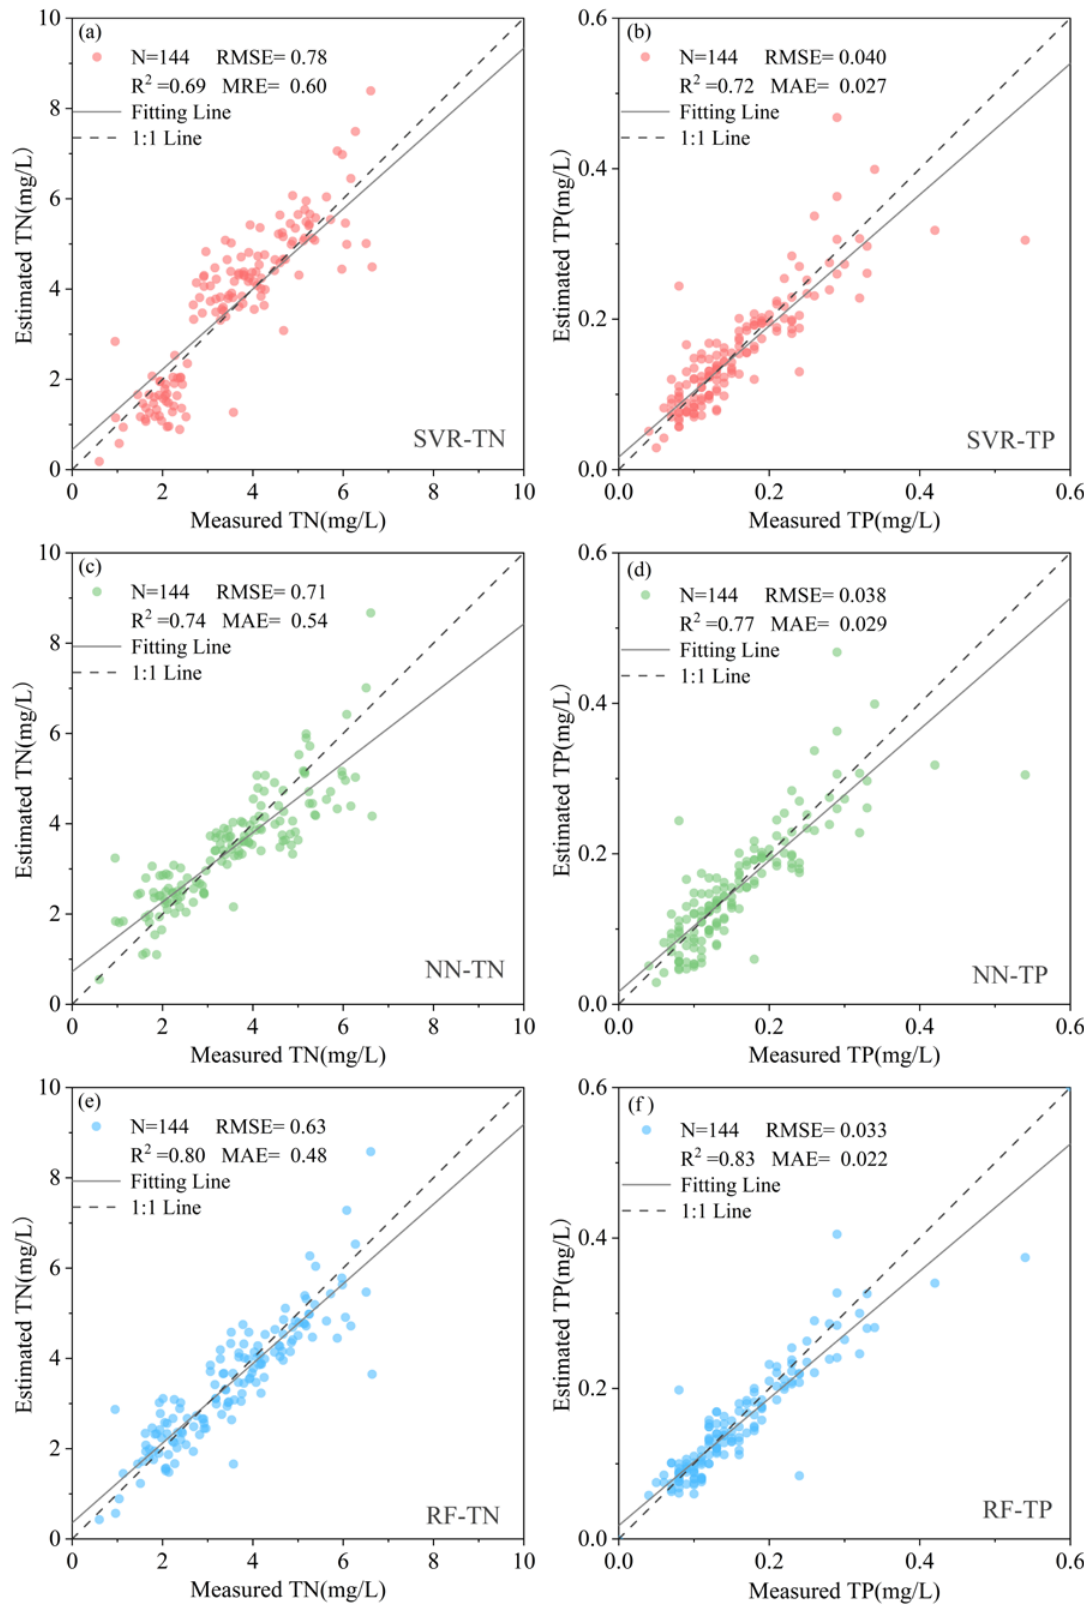
Figure 3. Performance evaluation of TN, TP inversion models based on all experimental data for SVR ( a , b ), NN ( c , d ) and RF ( e , f ).